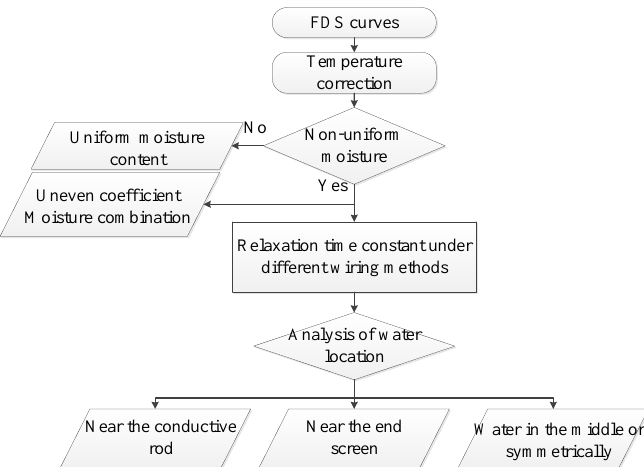
Figure 20. Flow chart for evaluating the distribution of moisture content.